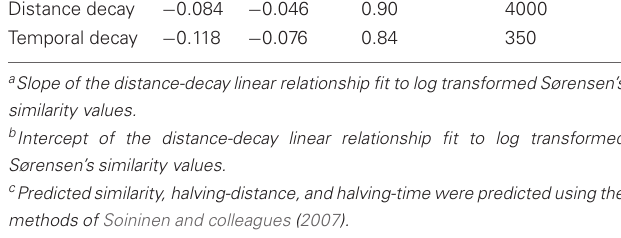
Comparisons were conducted using 68 samples from CB collected in 2003, 2005, and 2007 (previously unpublished), and 46 samples from ME collected in 2000, 2001, and 2005 (Shade et al.,